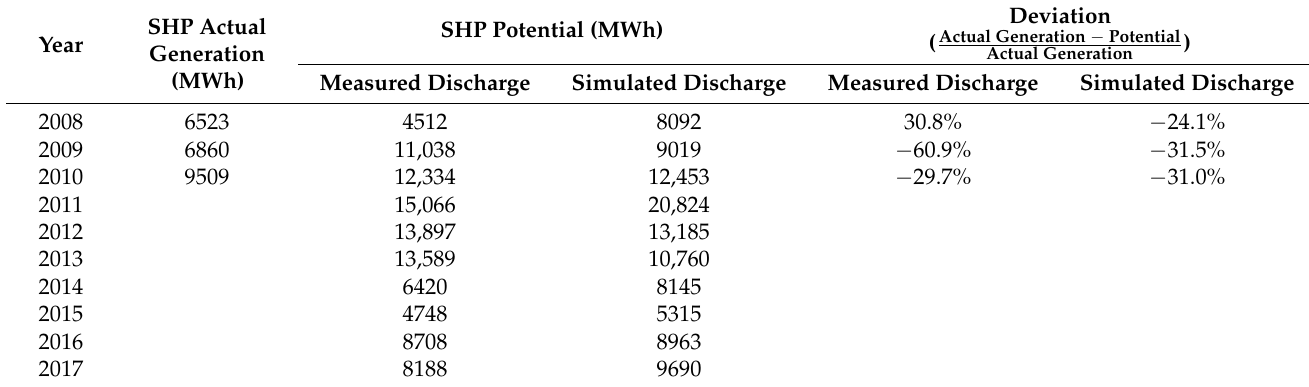
Table 13. Annual SHP potential result for the Hanseok SHP plant.